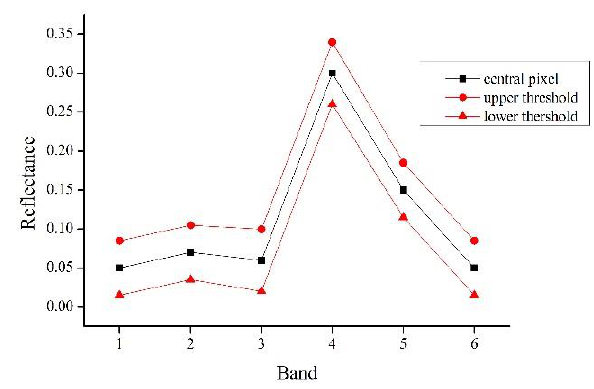
Figure 2. Spectral curves of the similar pixels selected by the threshold method.